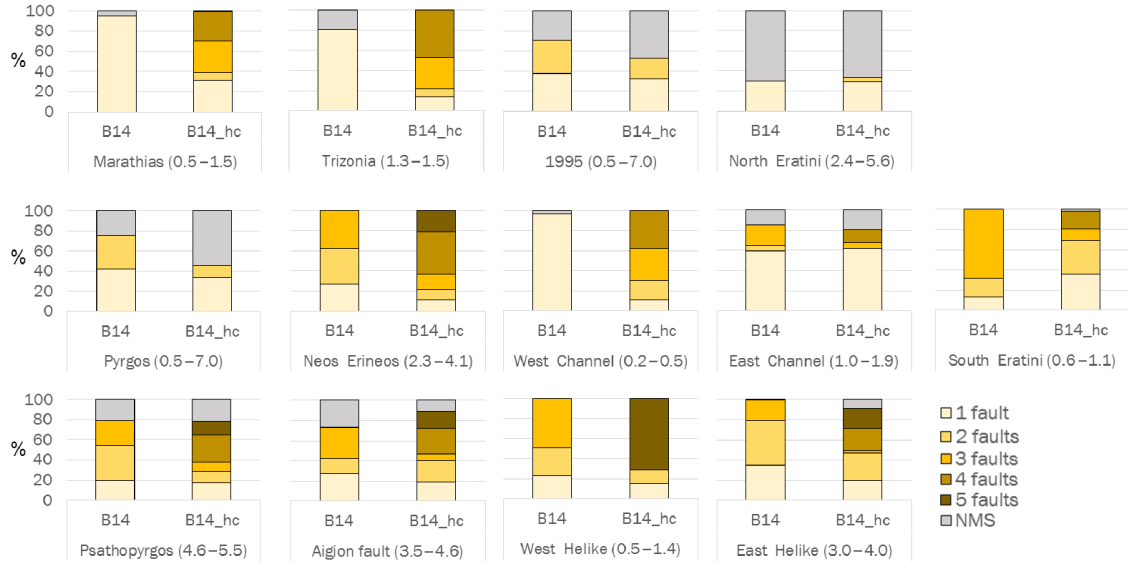
Figure 5. Visualization of the way the slip-rate budget of each fault is spent. The color depends on the number of faults involved in the FtF rupture. Minimum and maximum values of the slip rate on each fault is shown in brackets in mmyr − 1 .